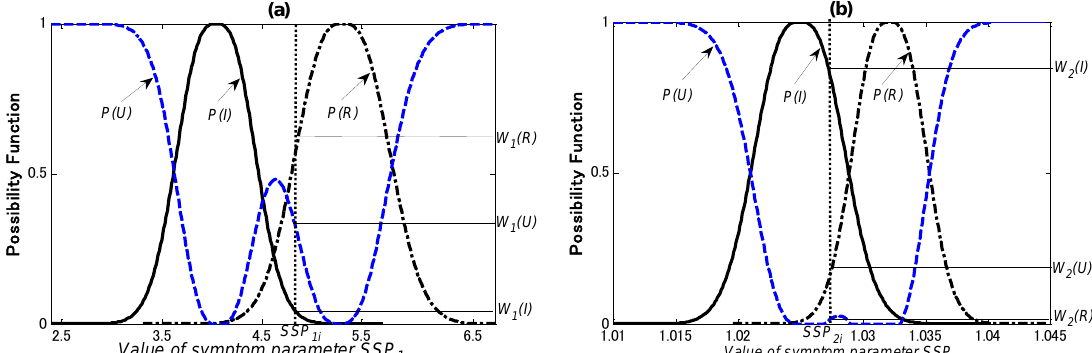
Figure 14. Possibility functions of ( a ) SSP